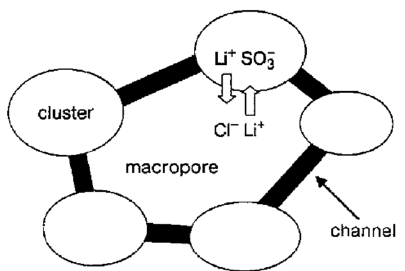
Figure 36. Structural model of CU-23 being in contact with a LiC1 aqueous solution. Adapted from [77].